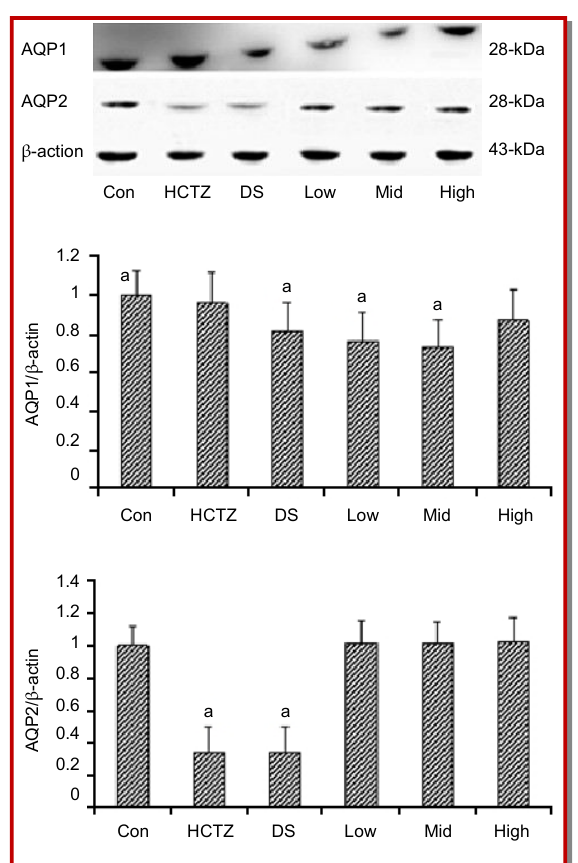
Figure 1: The expression of AQP1 in kidney cortex and AQP2 in kidney medulla tested by Western-blot method Con is control group, HCTZ is hydrochlorothiazide group, DS is D. sophia decoction group, Low is water elution